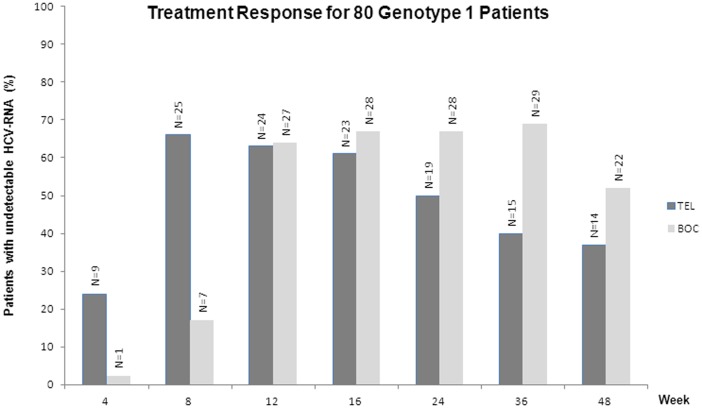
Treatment response for 38 TEL-treated and 42 BOC-treated patients.